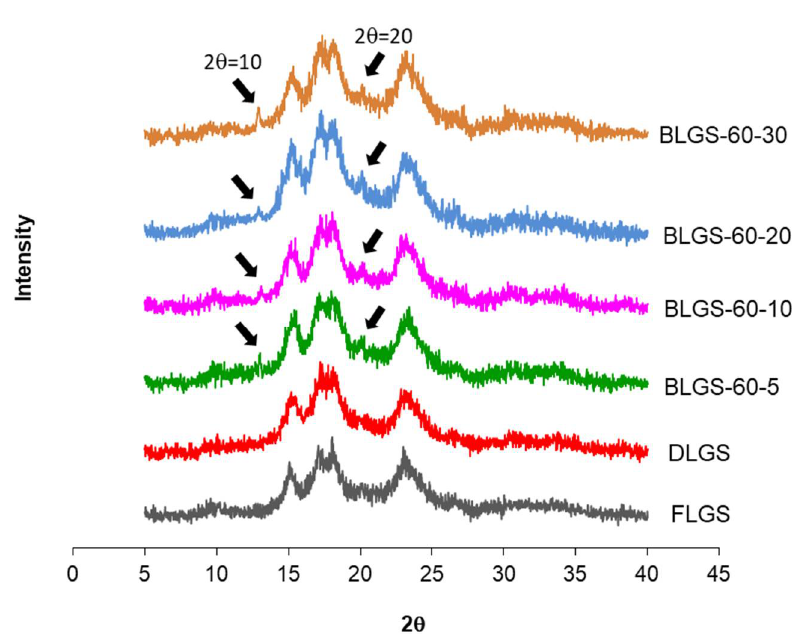
Figure 2. Representative XRD images of longan starches extracted from seeds of fresh fruits (FLGS), oven-dried fruits (DLGS), and “black longan” fruits incubated at 60 °C for 5, 10, 20, and 30 days (BLGS-60-5, BLGS-60-10, BLGS-60-20, BLGS- 60-30).